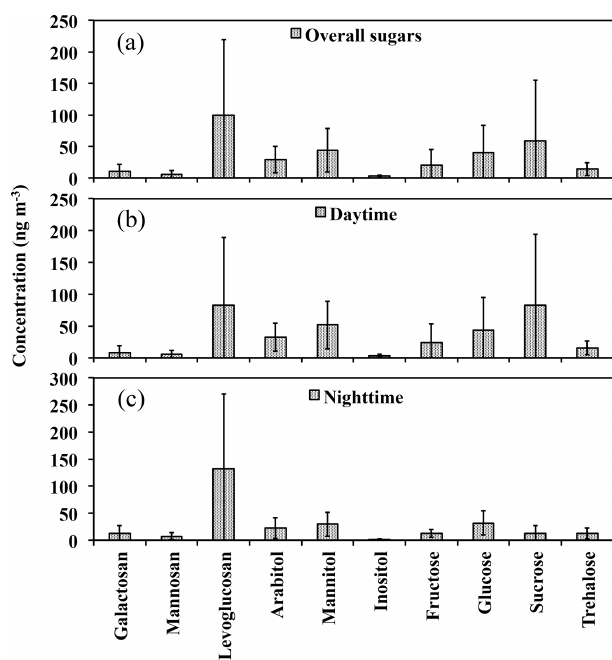
Figure 3. Concentrations (ngm − 3 ) of sugar compound (a) overall, (b) in the daytime, and (c) at nighttime in aerosol samples from Mangshan during September–October 2007 (the error bars denote the standard